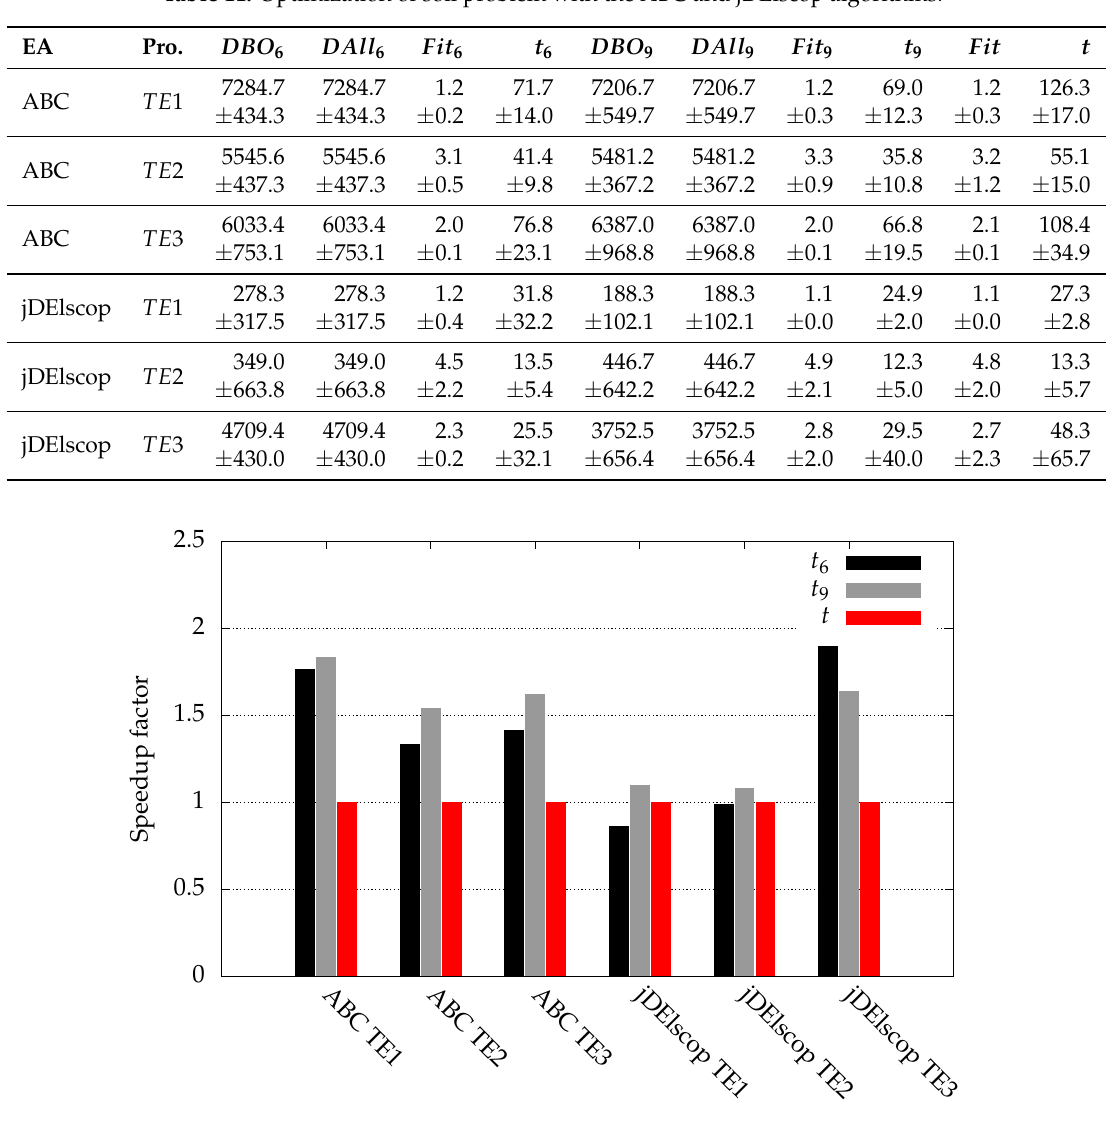
Figure 10. Average speedup for a single